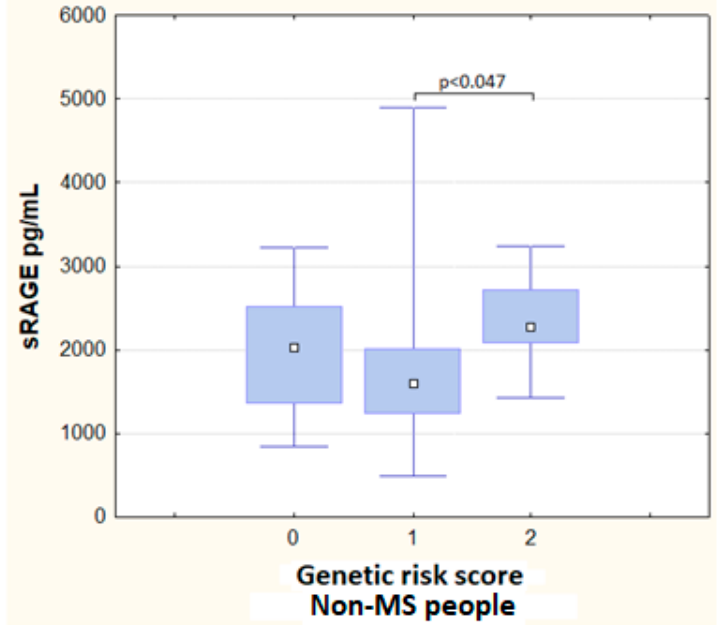
Figure 3. Serum levels of sRAGE by genetic risk score among Non-MS subjects. Table 5. Association of haplotypes with metabolic syndrome.